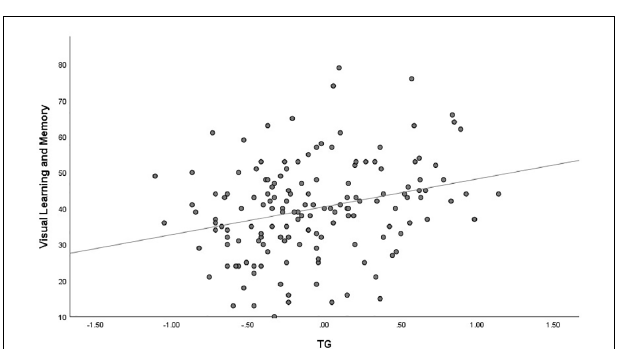
FIGURE 2 | MCCB visual learning and memory score was positively associated with triglyceride (TG) of the total number of study patients ( p < 0.001).